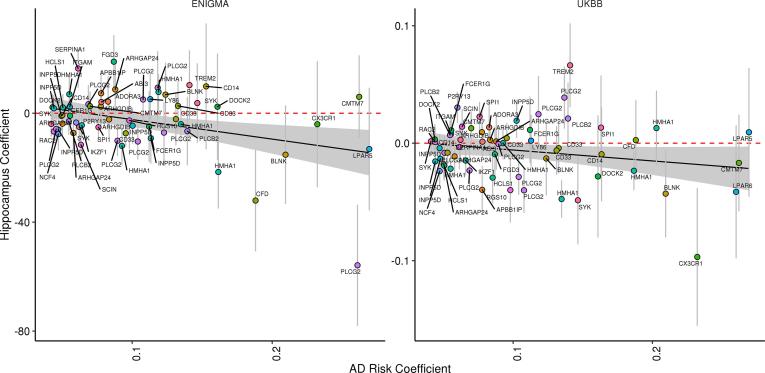
Diagnostic plots for microglia SNP sets for ENIGMA (N = 13,163; left: β = −26.9, P = 0.016, NSNPS = 60) and UK Biobank (N = 9707; right: β = −0.05, P = 0.027, NSNPS = 61), both constrained to the P-threshold < 0.01. Each SNP is plotted by coefficient in the risk score (x axis) versus estimated effect size for HV in the testing dataset (y axis). The solid black line shows the effect size estimate for the risk score on HV in each of the testing datasets. Grey bar represents 95% confidence intervals.